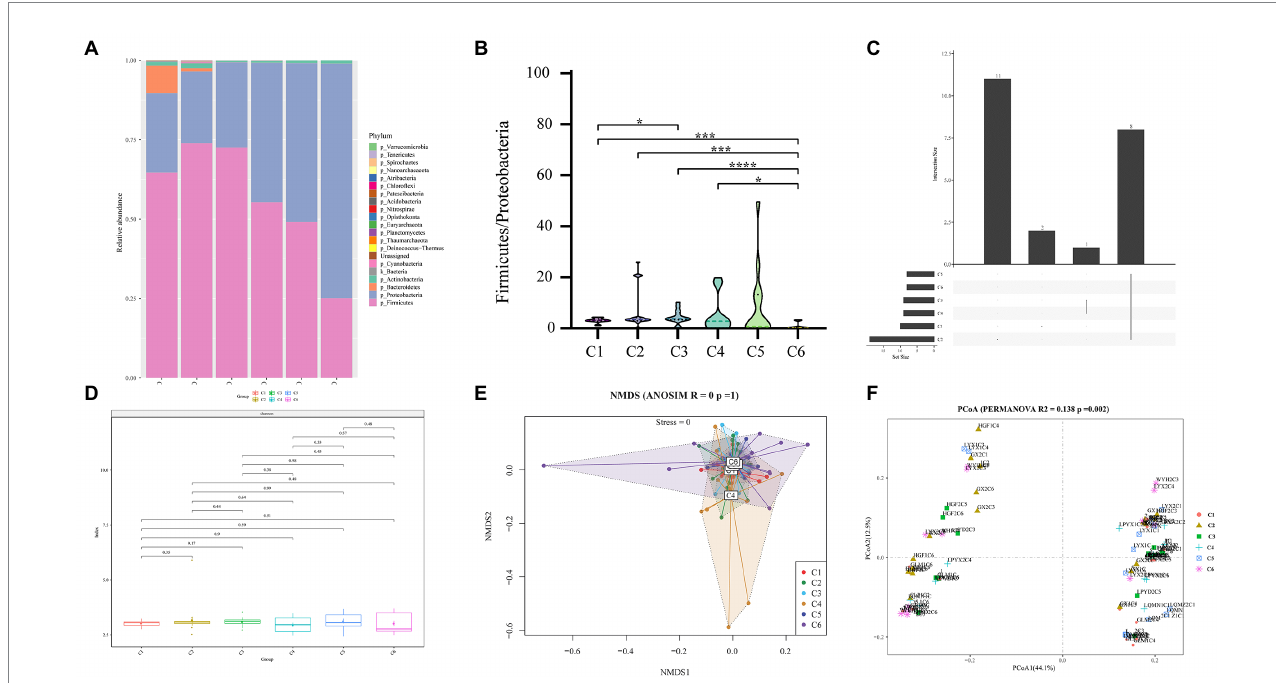
FIGURE 2 Comparison of relative abundances of intestinal microbial taxa across 6 age time points of preterm infants. (A) Composition of gut microbiota at the phylum level in the 6 age time points. (B) Box plot of F/P ratio among all groups (C1–C6). (C) Venn plot illustrating overlap of gut microbial phyla among six time point groups. Phyla detected in more than six fecal samples are included. (D) Alpha diversity and richness of bacterial communities across six groups using the Shannon index. (E) Beta diversity using NMDS of Bray–Curtis dissimilarity. (F) Unweighted Unifrac distance of gut microbiota between the time point groups. Pairwise p -values are calculated using a non-parametric Kruskal–Wallis test with Tukey post hoc test. * p < 0.05, ** p < 0.01, *** p < 0.001, **** p < 0.0001 were considered